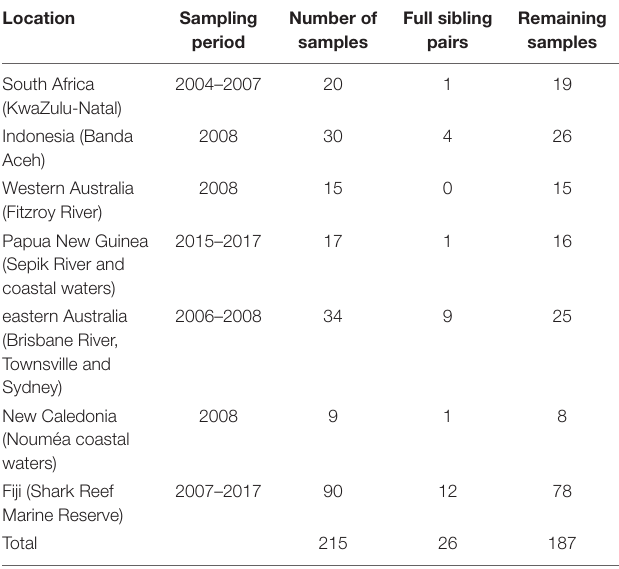
TABLE 1 | Number of original bull shark samples per location, full sibling pairs detected with COANCESTRY, and remaining samples after one individual for each pair was